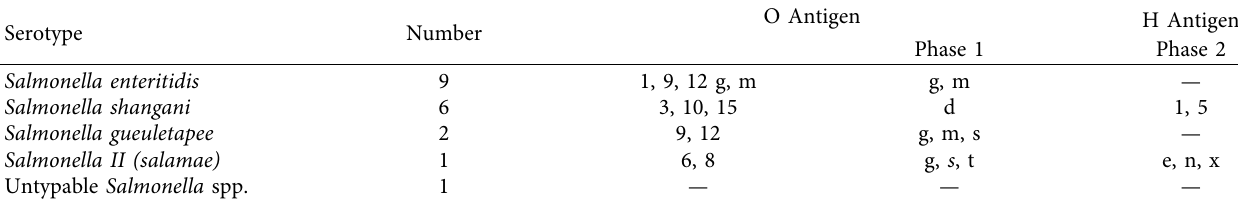
Table 4: : Results of the serological identifcation of Salmonella